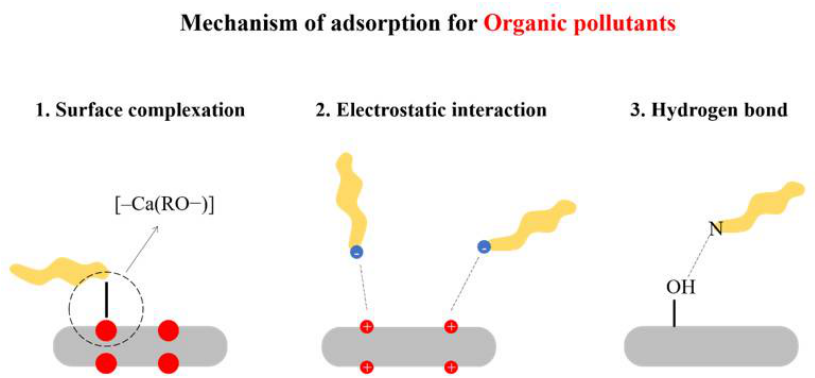
Figure 3. Adsorption mechanism of HAp for organic